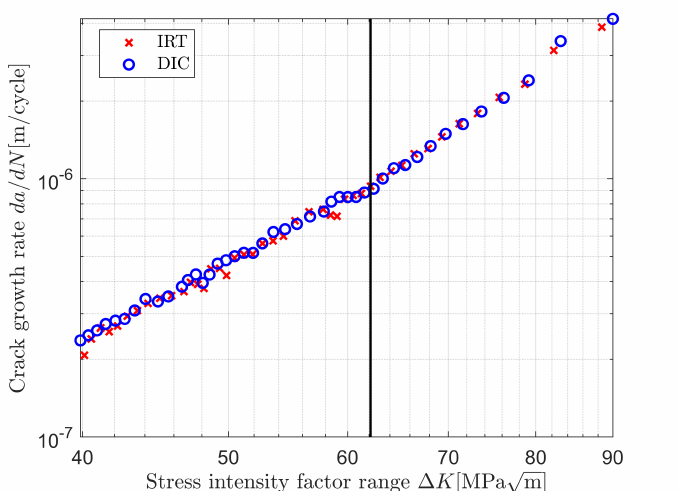
Figure 17. Paris plot obtained from IRT and DIC measurements. Both datasets are plotted for comparison. The vertical line represents the LEFM limit according to the small yielding